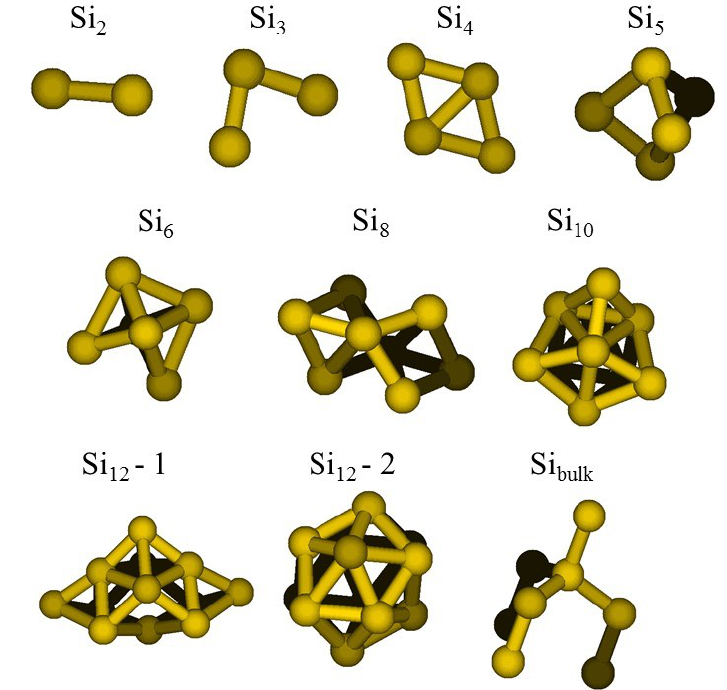
Figure 2. Si clusters included in the training set used in the FF